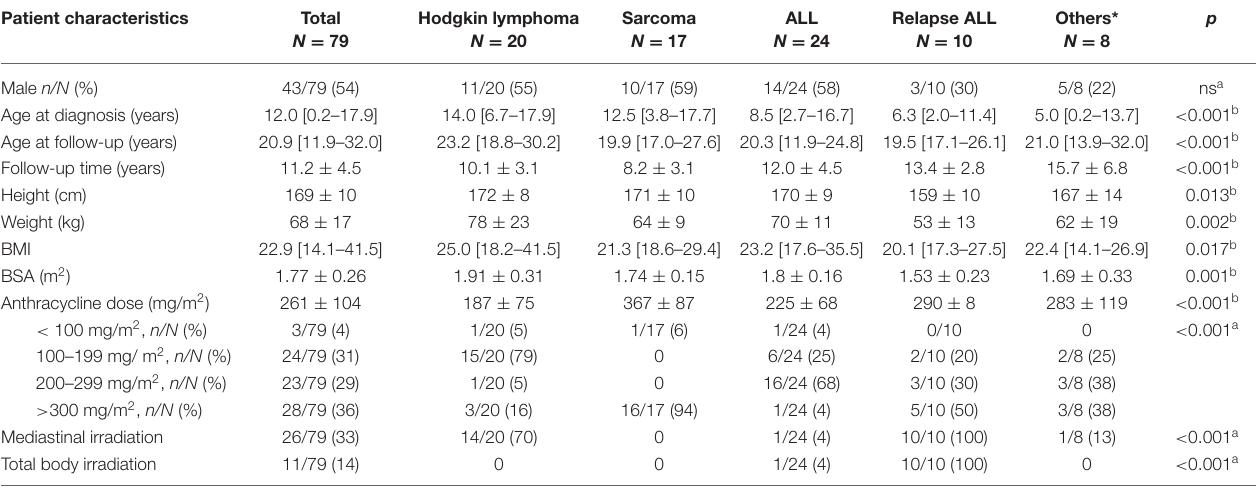
TABLE 1 | Patient